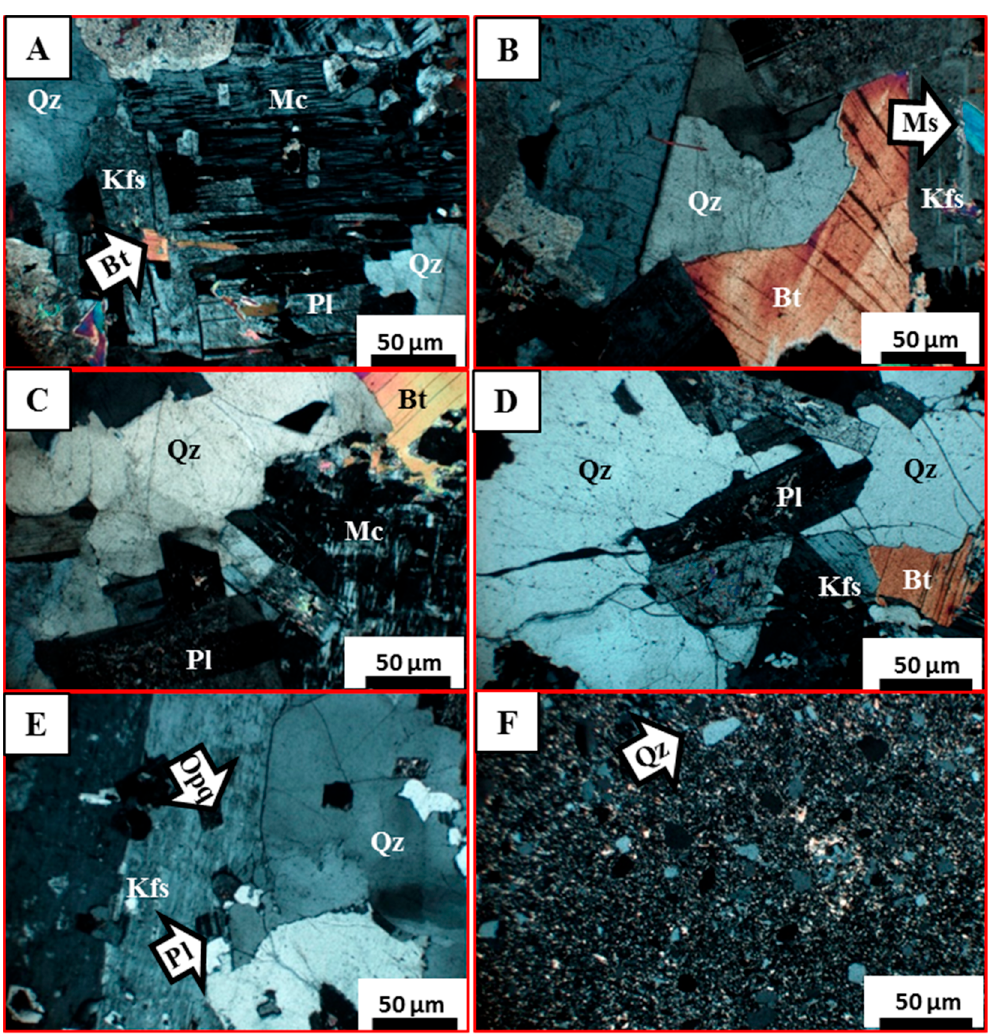
Figure 4. Photomicrographs of granitoids and greywacke at the Tagu tin–tungsten deposit. ( A ). Microcline associated with plagioclase and K-feldspar with a small amount of biotite in granite; ( B ). biotite associated with quartz and K-feldspar with the secondary muscovite in granite; ( C ). plagioclase associated with microcline and biotite in granite; ( D ). K-feldspar associated with biotite and plagioclase which is altered to sericite in granite; ( E ). Quartz occurring with plagioclase and K-feldspar, which has opaque minerals in granite; and ( F ). greywacke under microscope. Abbreviations: Qz = quartz, Pl = plagioclase, Kfs = K-feldspar, Bt = Biotite, Ms = muscovite, Mc = microcline, Opq = opaque mineral.